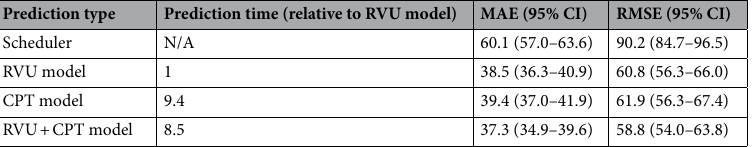
Table 4. Model and scheduler performance